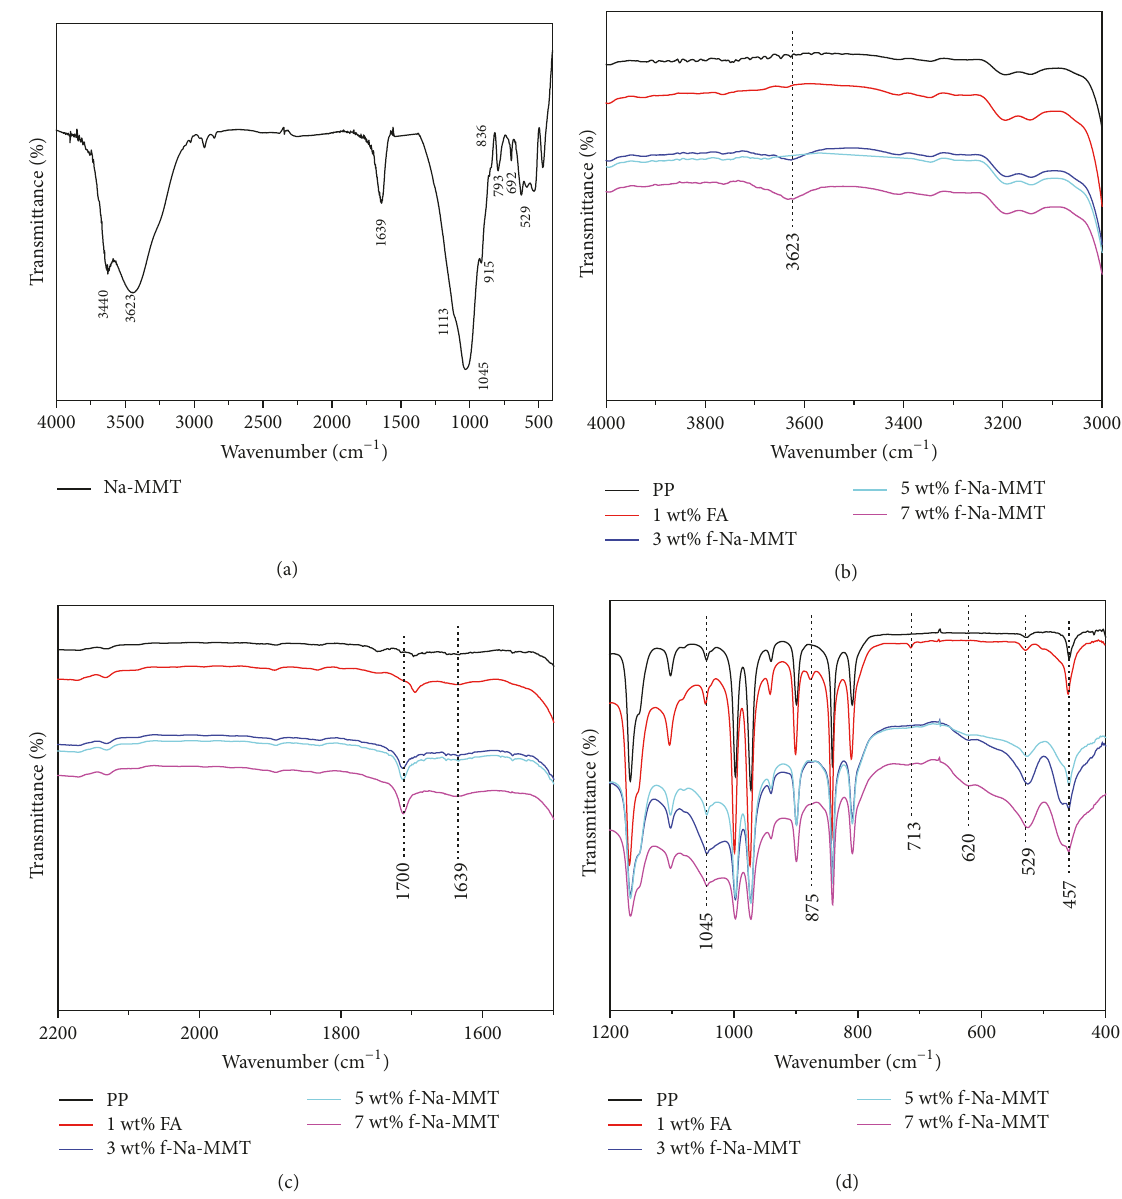
Figure 1: Fourier transform infrared spectroscopy (FTIR) spectra of (a) unmodified Na-MMT; (b, c, d) PP; PP/1wt% FA crosslinked PP; 3, 5, and 7 wt% f-Na-MMT